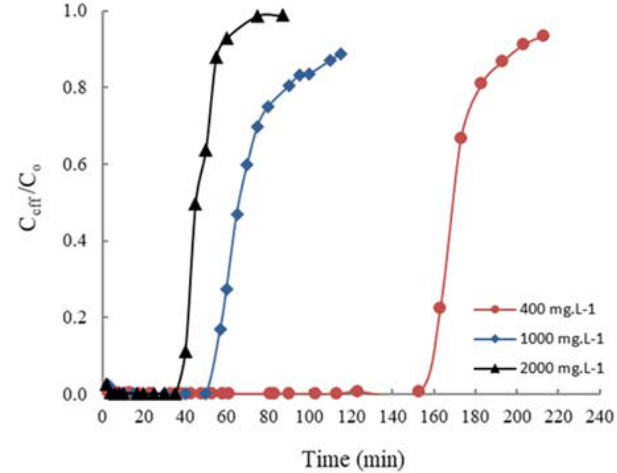
Figure 4. Concentration effect of the influent phenol on the curve of breakthrough of phenol adsorp- tion of RHAC (rate of flow given as 10 mL · min − 1 ; bed depth given as 8.5 cm).